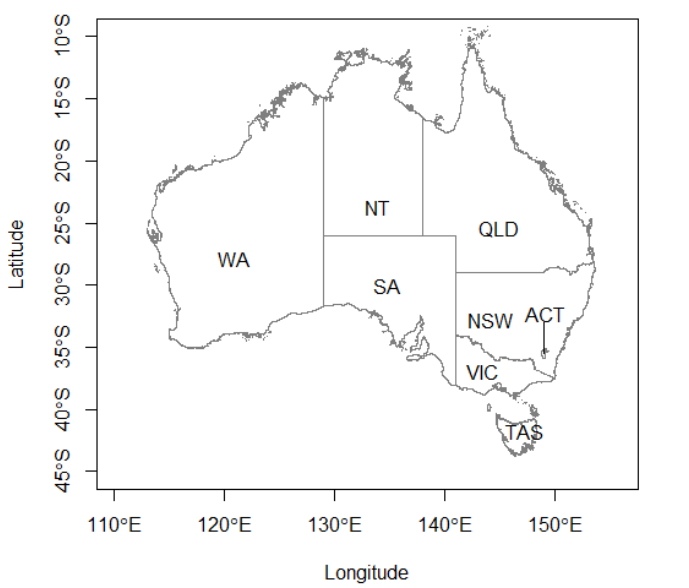
Figure 1. Map of Australia with the states and territories